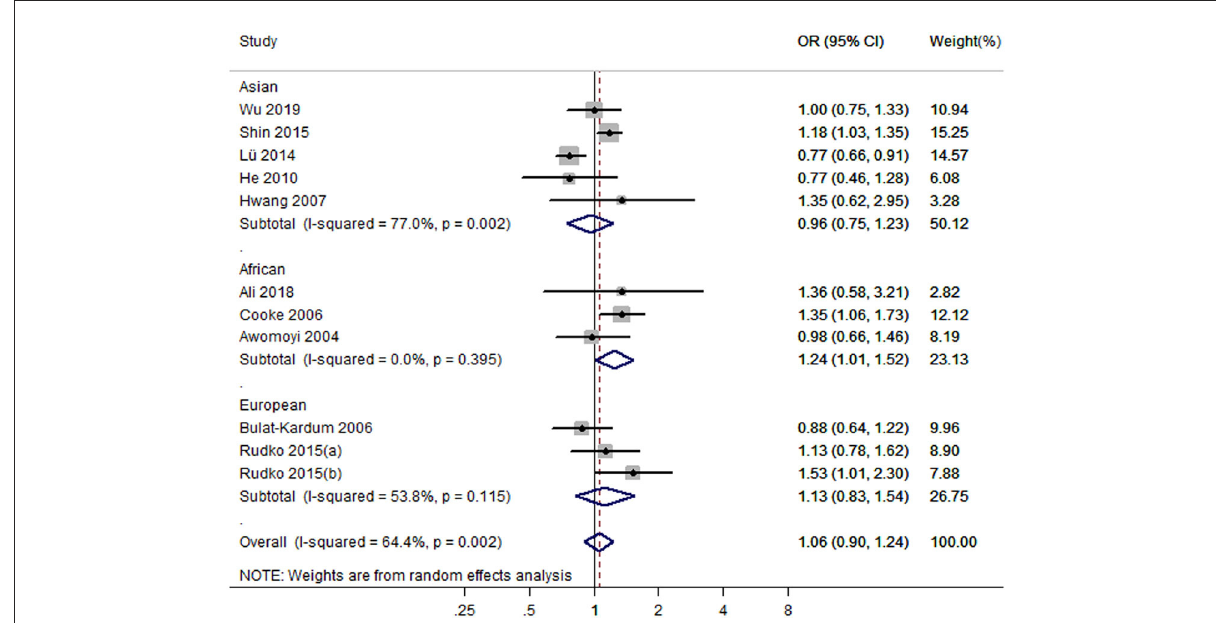
FIGURE2 Forest plot of association between IFNGR1 rs2234711 polymorphism and tuberculosis susceptibility (dominant model: CC + CT vs.